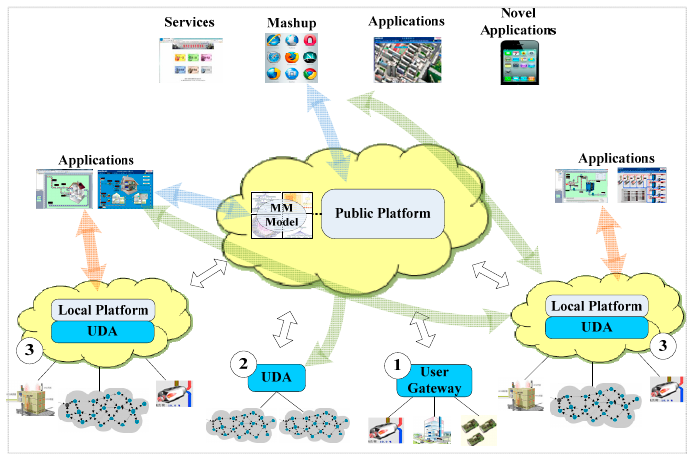
Figure 1. Framework Overview.